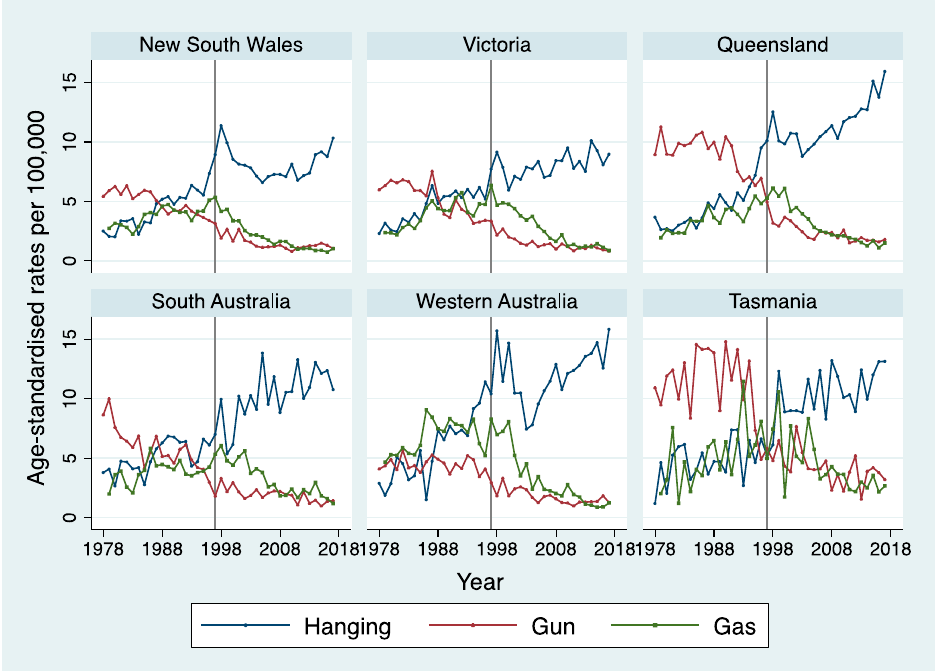
Figure 2. Age ‐ standardised suicide mortality rate per 100,000 by method separately by state among men. The grey line in 1997 represents the year when the National Firearms Agreement was introduced in Australia and separates the 40 ‐ year study period into two halves.